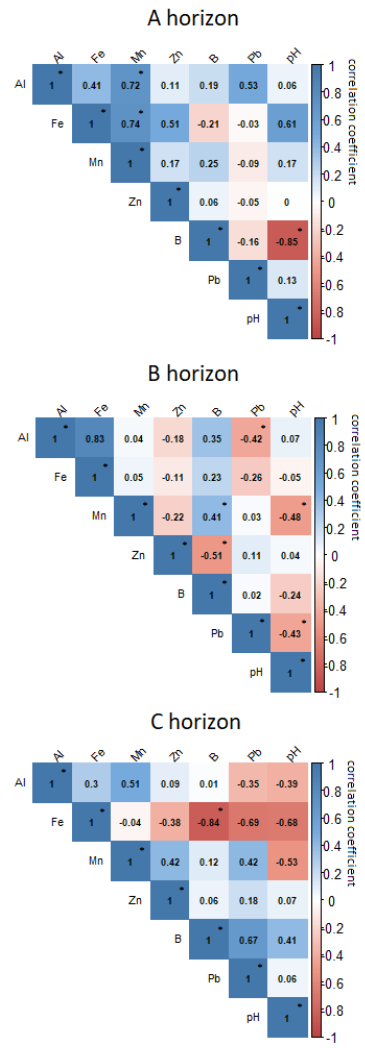
Figure 4. Correlation matrices for the different minor elements and pH analysed by master horizon (A, B, and C). The values in the matrices are the Pearson correlation coefficients, calculated from the 11 soil characteristics obtained from each profile. Red cells–negative relationships; blue cells–positive correlations; asterisks–statistically significant correlations ( p < 0.05).